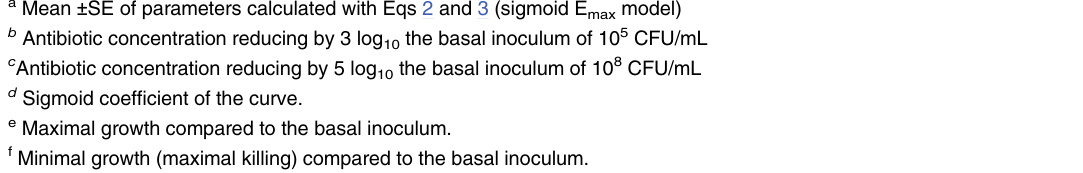
max model) 5 CFU/mL 10 the basal inoculum of 10 8 CFU/mL 10 the basal inoculum of 10